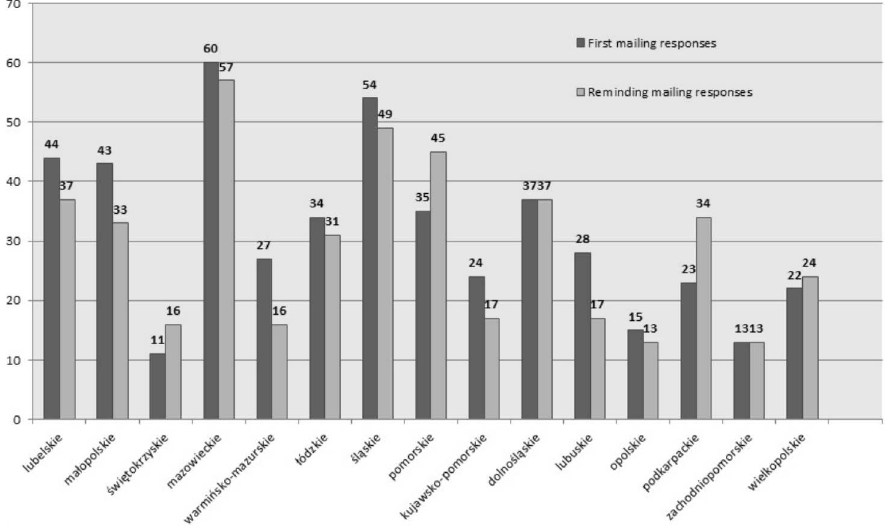
Figure 2. Comparison of responses: First mailing vs